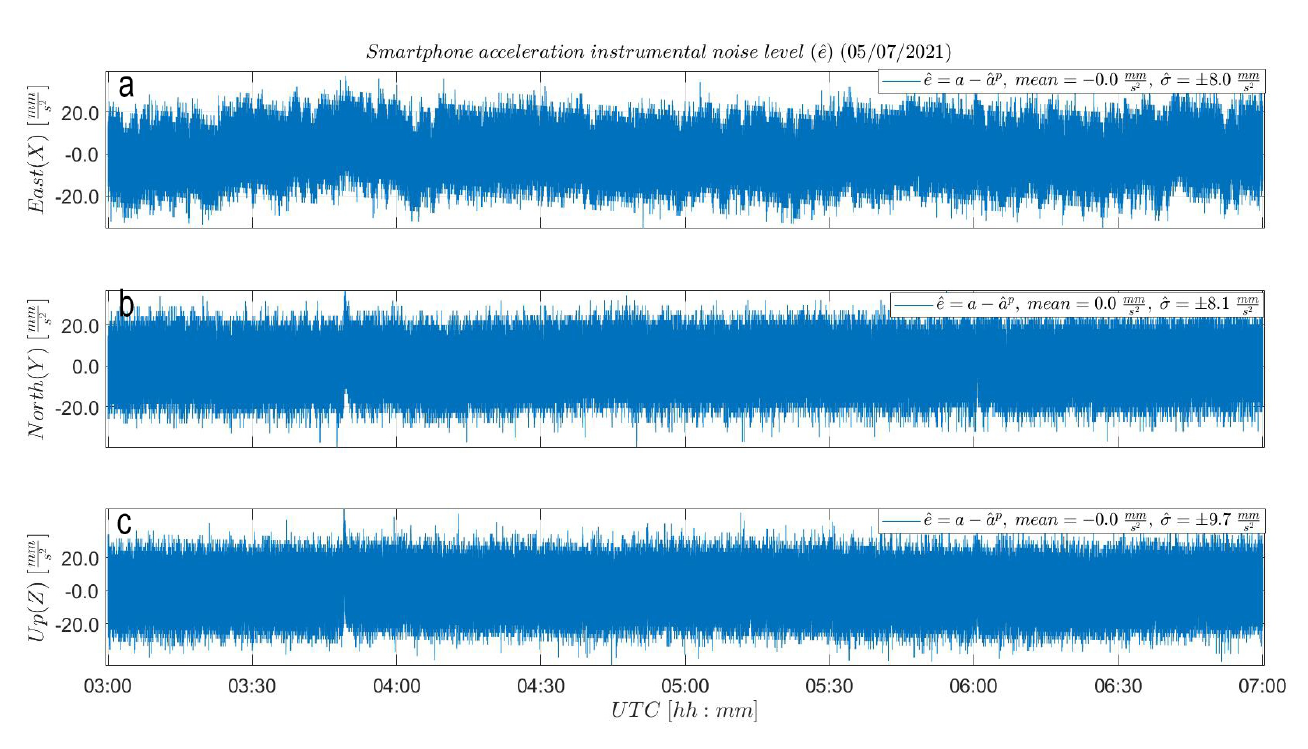
Figure 4. Smartphone accelerometer empirical noise (ˆ e ) analysis: ( a ) East, ( b ) North and ( c ) Up noise level of a four-hour- long sequence (after initiation) from the steady MI acceleration time series. Resulting ENU instrumental noise time series show a variability (ˆ σ ) of ± 8.0, 8.1 and 9.7 mm , s 2